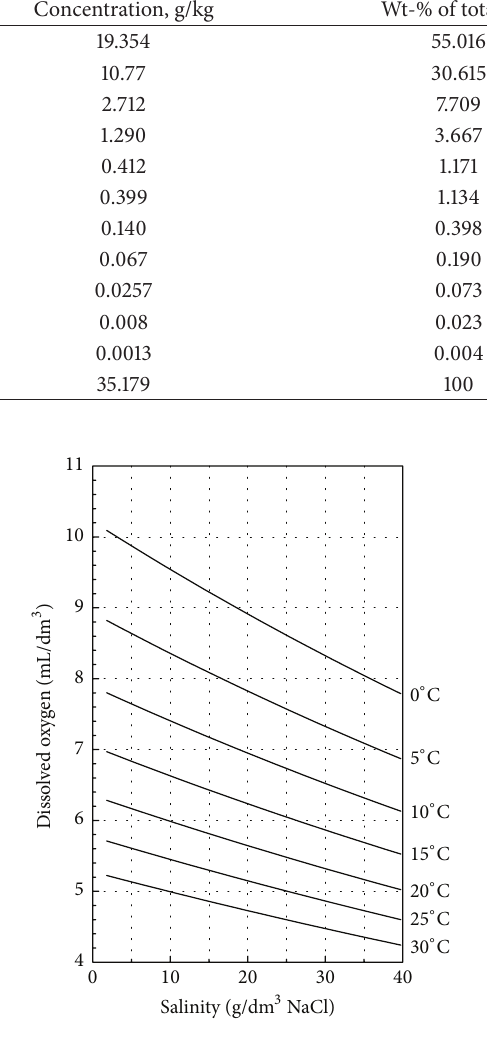
Figure 2: Seawater dissolved oxygen as a function of salinity and temperature calculated using (1)